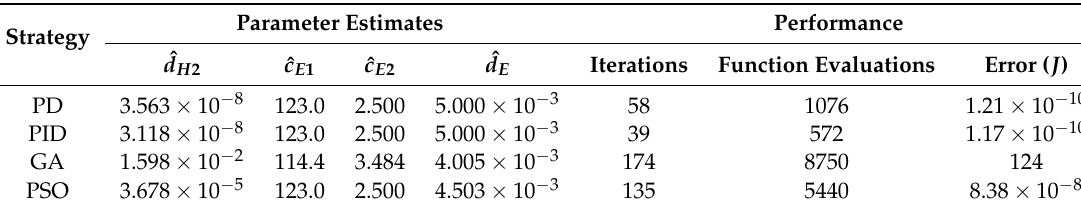
Table 6. Performance of optimization strategies for the hydraulic engine mount system using proportional–derivative controller (PD), proportional–integral–derivative controller (PID), genetic algorithm (GA), and particle swarm optimization (PSO) approaches.